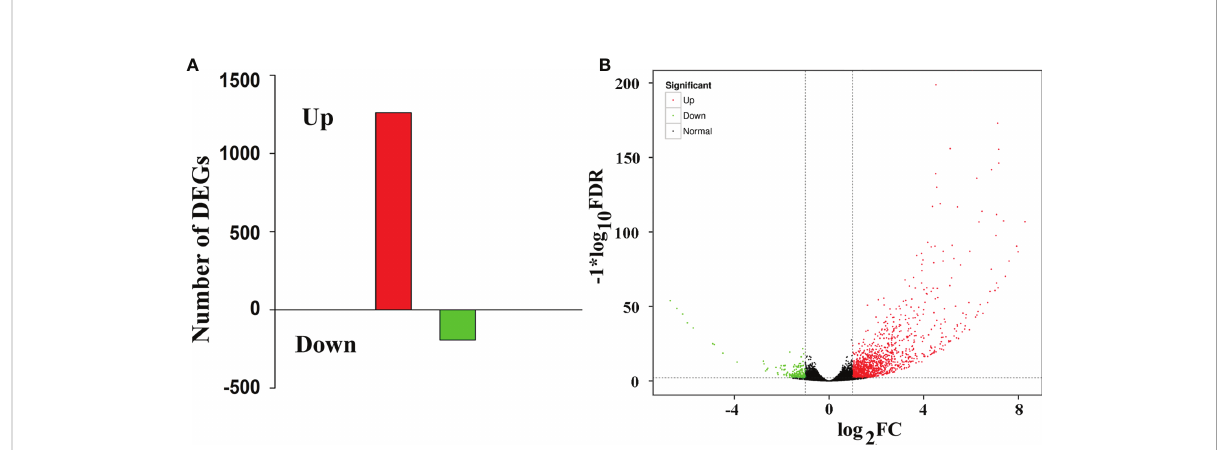
FIGURE 2 RNA-Seq analyses of WT and LMM 5386 . (A) Changes in the gene expression pro fi les in WT- and LMM 5386 -line fl ag leaves; (B) differentially expressed genes (DEGs). Values are means ± SD based on three